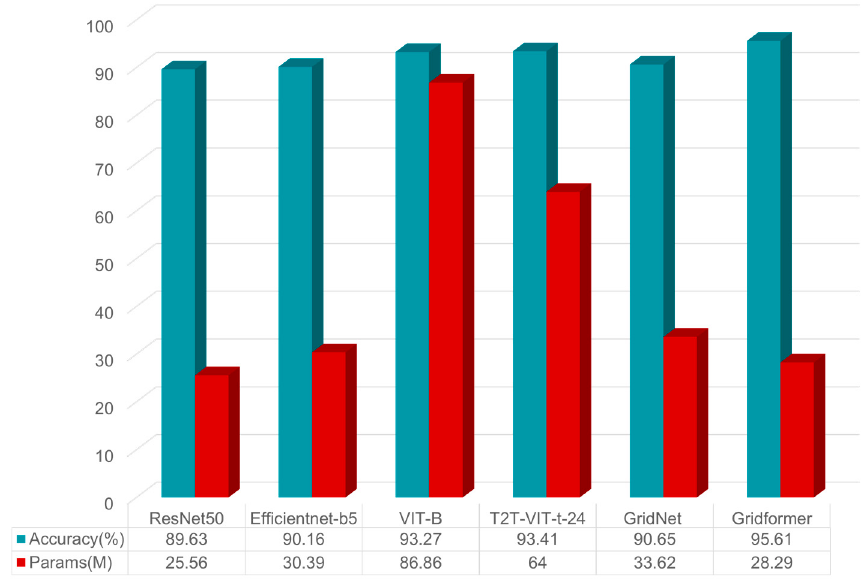
Figure 13. Prediction accuracy of different neural networks on the NACA-Market.